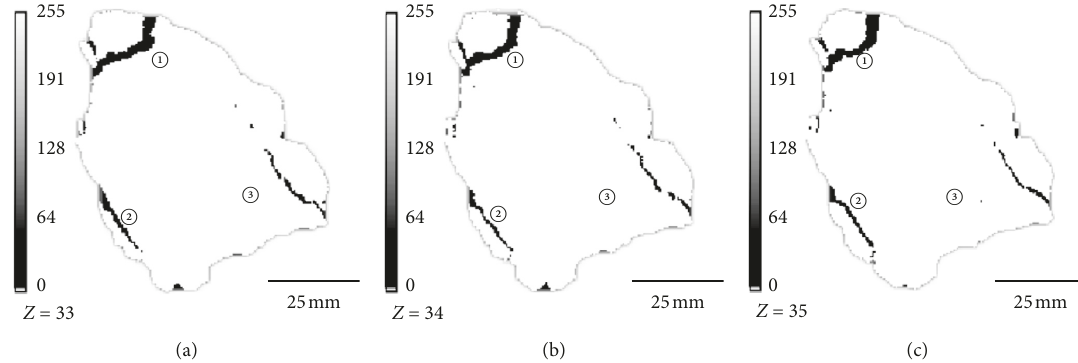
Figure 11: Slices of coal obtained from the CTimage and the corresponding initial isolation of segmented cracks (black). Delineation of the particle boundary is shown in grey color. Table 2: Quantitative analysis of coal internal cracks in the selected three slices. CT slice Crack